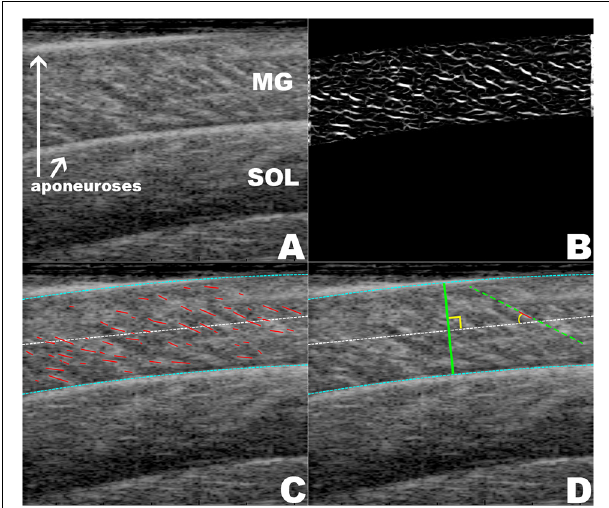
FIGURE 2 | Depictions of the ultrasound data analysis. (A ) A raw ultrasound frame with medial gastrocnemius (MG), soleus (SOL), and aponeuroses shown. (B) The result of the multiscale vessel enhancement filter applied to the ultrasound frame. (C) The digitization of the aponeuroses (blue) and the fascicle lines (red). (D) Shown are the measurement of the muscle thickness and the pennation angle of a